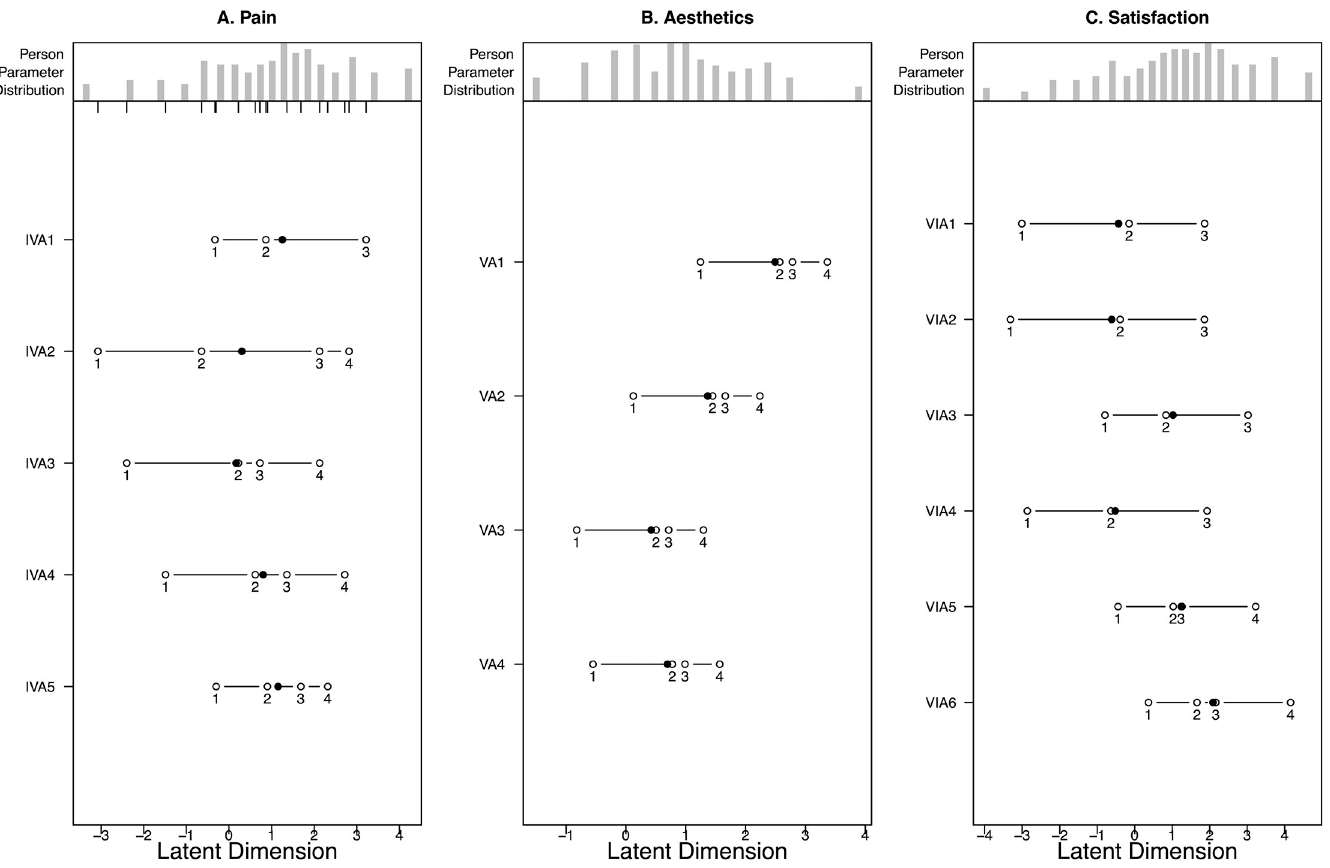
Fig 3. Person-Item Map and Threshold Ordering for Pain (3a, left), Aesthetics (3b, middle), and Satisfaction after collapsing disordered thresholds (3c, right).